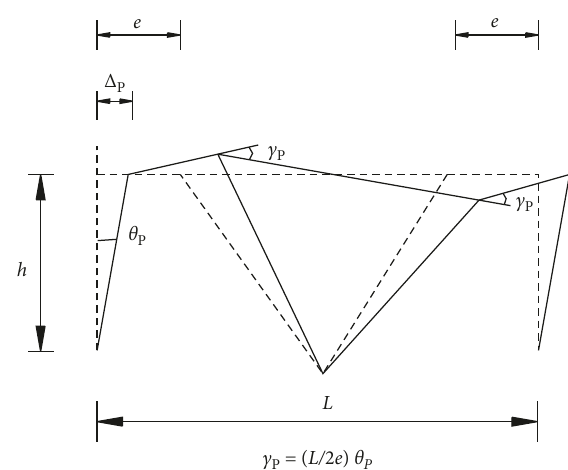
Figure 3: Link rotation angle of